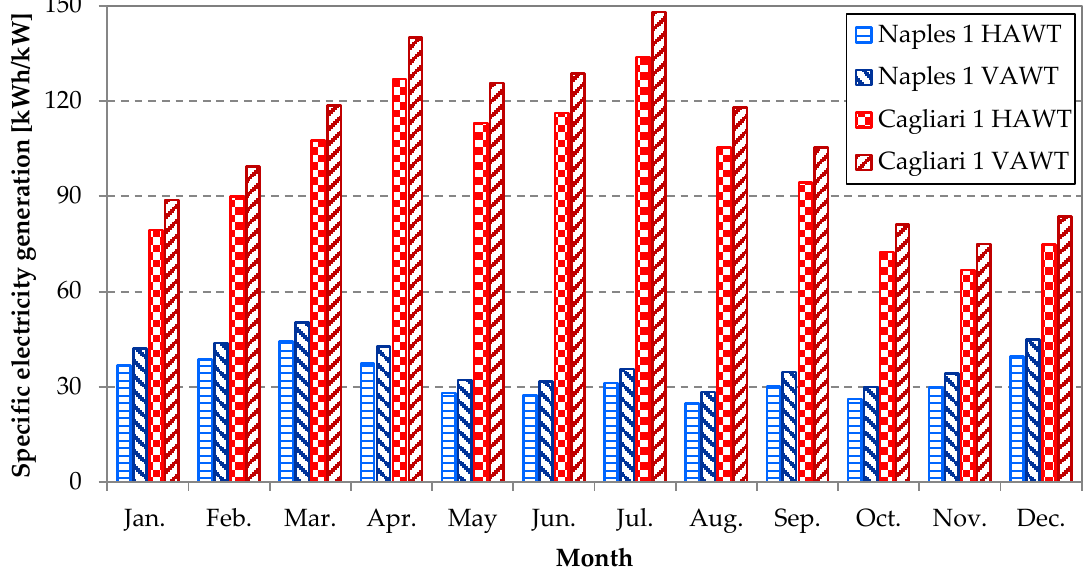
Figure 9. HAWT and VAWT specific electricity generation on a monthly basis for both Naples and Cagliari. Table 5. Annual electricity demand of the end-user.